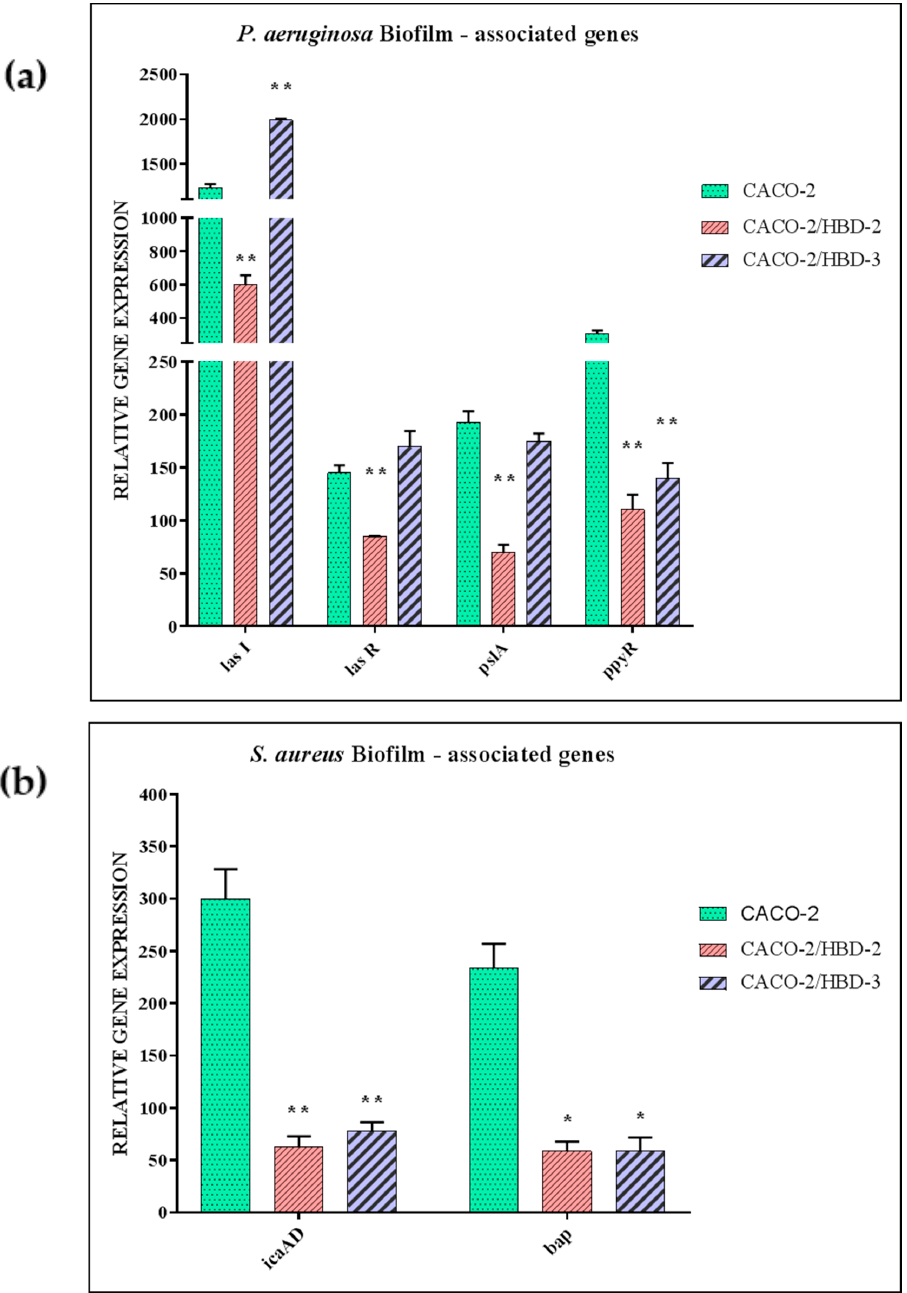
Figure 4. Real-Time PCR results show the effects of HBD-2 and HBD-3 on expression of biofilm- associated genes in P. aeruginosa ( a ) and S. aureus ( b ) re-suspended in conditioned media in Caco- 2/HBD-2 and Caco-2/HBD-3 cells, shown as relative gene expression. Data are representative of three different experiments ± SD. Significant differences are indicated by * p < 0.05, ** p < 0.01.